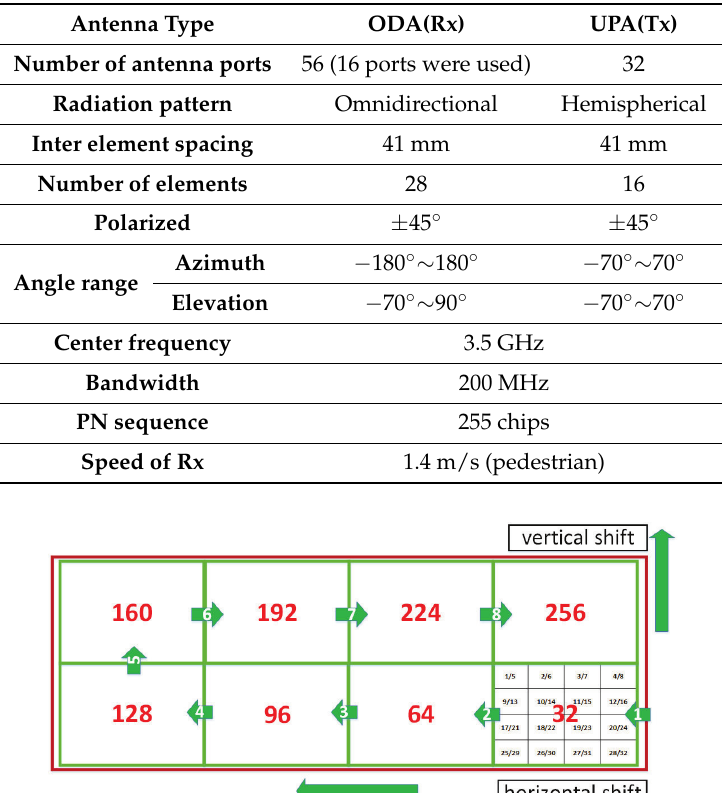
Figure 2. Antenna used in the measurement. ( a ) Tx: 4 × 4 patches, with each patch comprising a pair of cross-polarized antennas. ( b ) Rx: 8 adjacent sides with 3 patches each, a top surface with 4 patches; each patch contains a pair of cross-polarized antennas. Table 1. Specifications of measurement campaign.